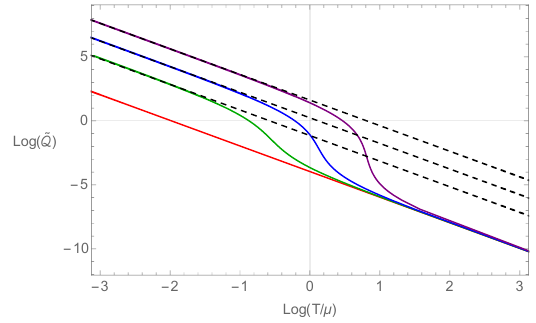
Figure 1 . log ~ Q vs log (cid:22) T . The solid curves correspond to (cid:22) (cid:12) = 0 : 1 ; 5 ; 10 ; 20 (Red, Green, Blue, Purple). The black dashed line represents